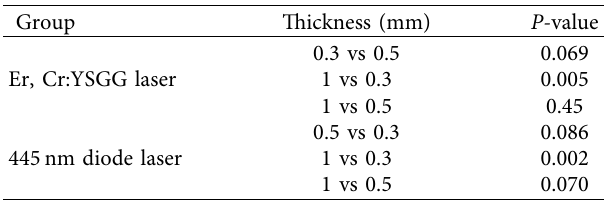
Table 4: Two-by-two examination of thicknesses in two groups of Er, Cr:YSGG laser and 445nm diode laser.